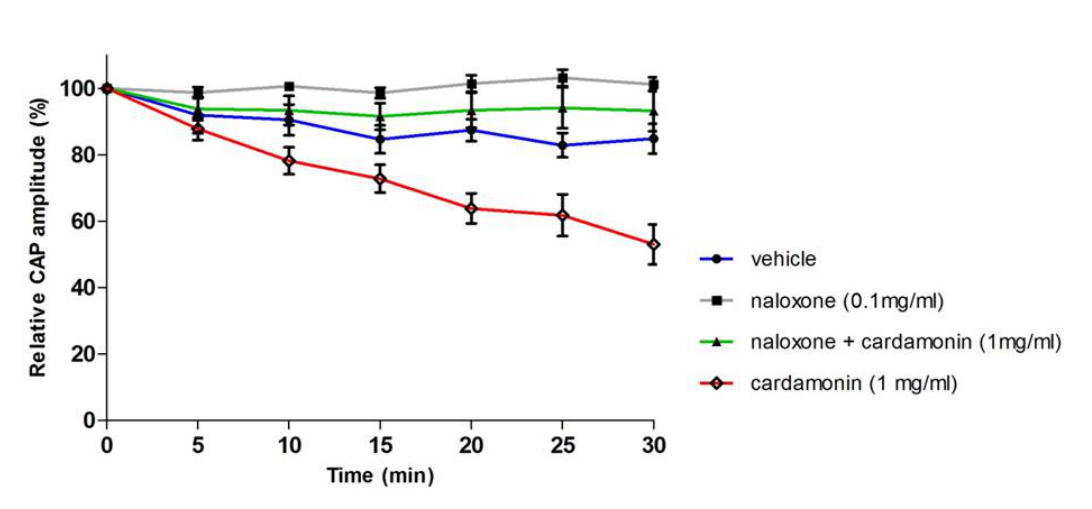
Figure 4: Effect of pre-treatment of naloxone (0.1 mg/mL) with cardamonin on the CAPs amplitude of frog sciatic